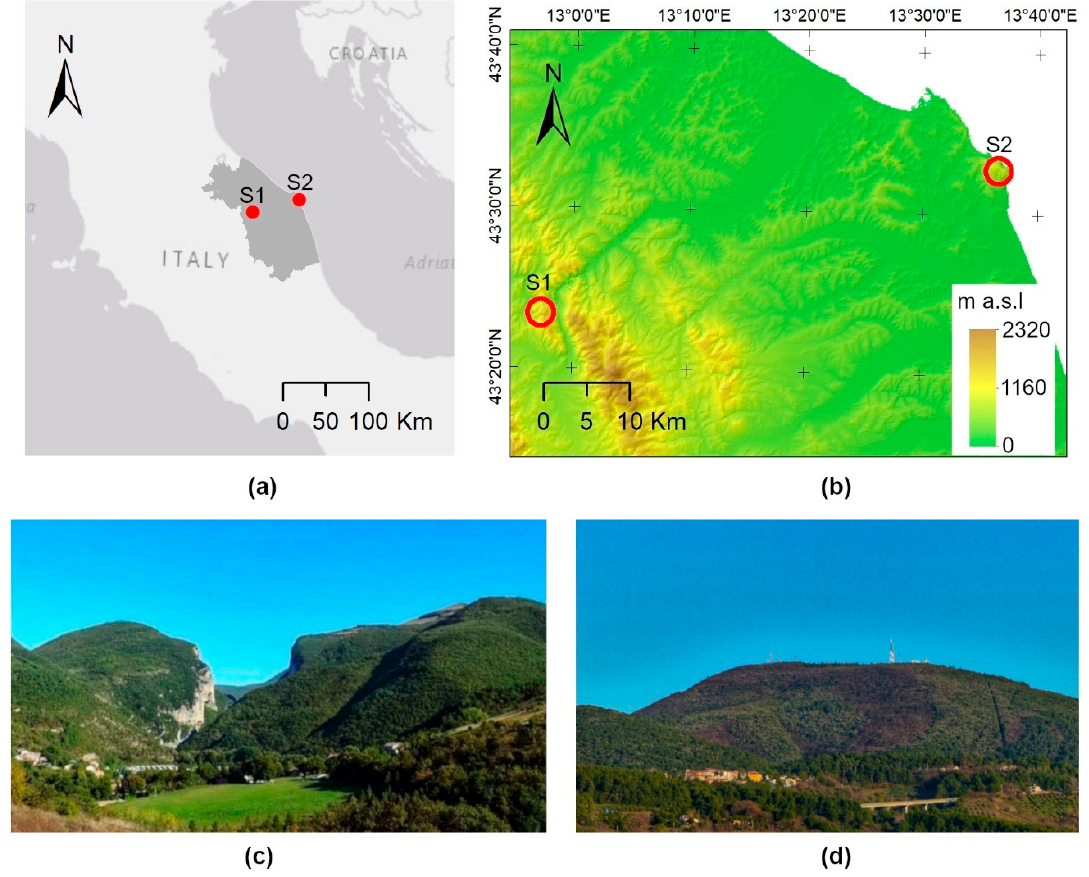
Figure 2. Study areas. ( a ) Location map of Mount Valmontagnana (S1) and Mount Conero (S2) areas (Marche region, central Italy). ( b ). Elevation map (m a.s.l). ( c ) Forest landscape of Mount Valmontagnana area (S1; photo of 28 June 2019). ( d ) Forest landscape of Mount Conero area (S2; Photo of 20 February 2020).